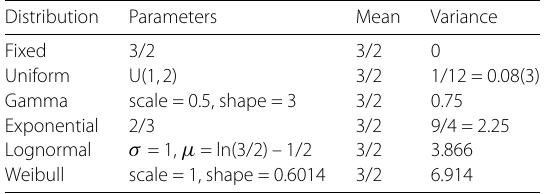
Table 1 Details of all the distributions of the infection times used for the explicit stochastic network